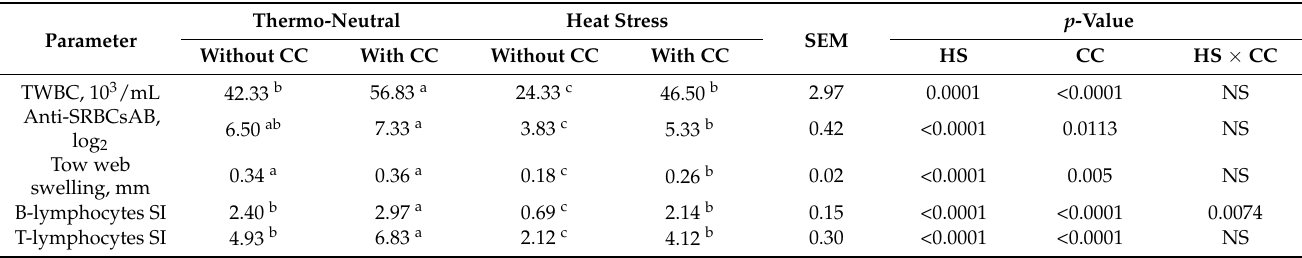
Table 4. Immunological parameters of broilers reared under thermo-neutral (control) or cyclic heat-stress (HS) condition and with or without Citrullus colocynthis (CC) seeds supplementation.